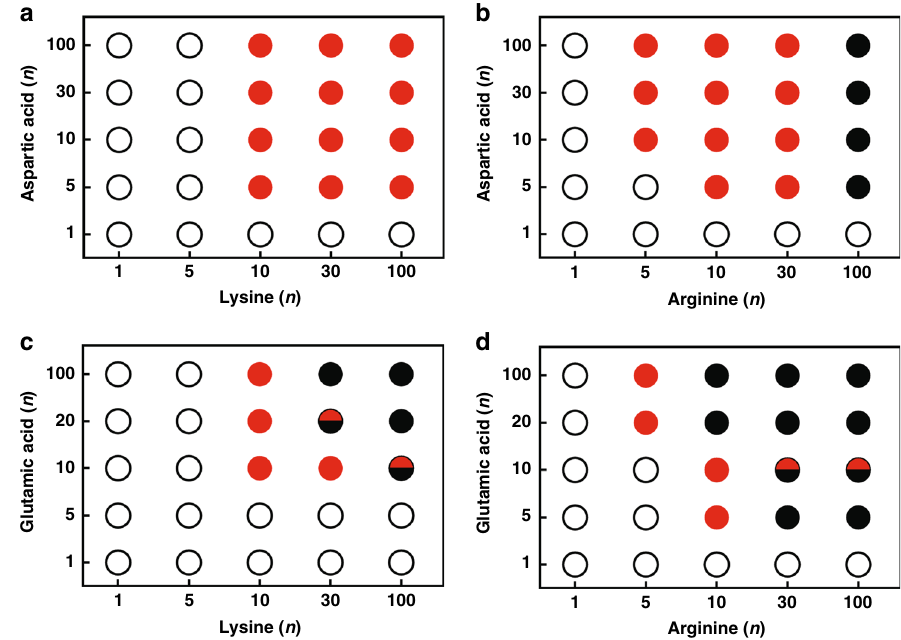
Fig. 2 Coacervation results obtained by combining pairs of oppositely charged peptides. Polyanions ((Asp) n or (Glu) n ) were mixed with polycations ((Lys) n or (Arg) n ) at 10 mM charge for each peptide, and 1:1 charge ratio. Formation result of pairs of peptides of a (Lys) n /(Asp) n , b (Arg) n /(Asp) n , c (Lys) n /(Glu) n , and d (Arg) n /(Glu) n where n = 1, 5, 10, 20, 30, or 100. Symbols indicate observation of uniform solution (white circles), coacervates (red circles), aggregates (black circles),or both aggregates and coacervates (half red and half black circles). Images are obtained over analysis of at least three independent trials and phase diagrams are result of these observations along with turbidity